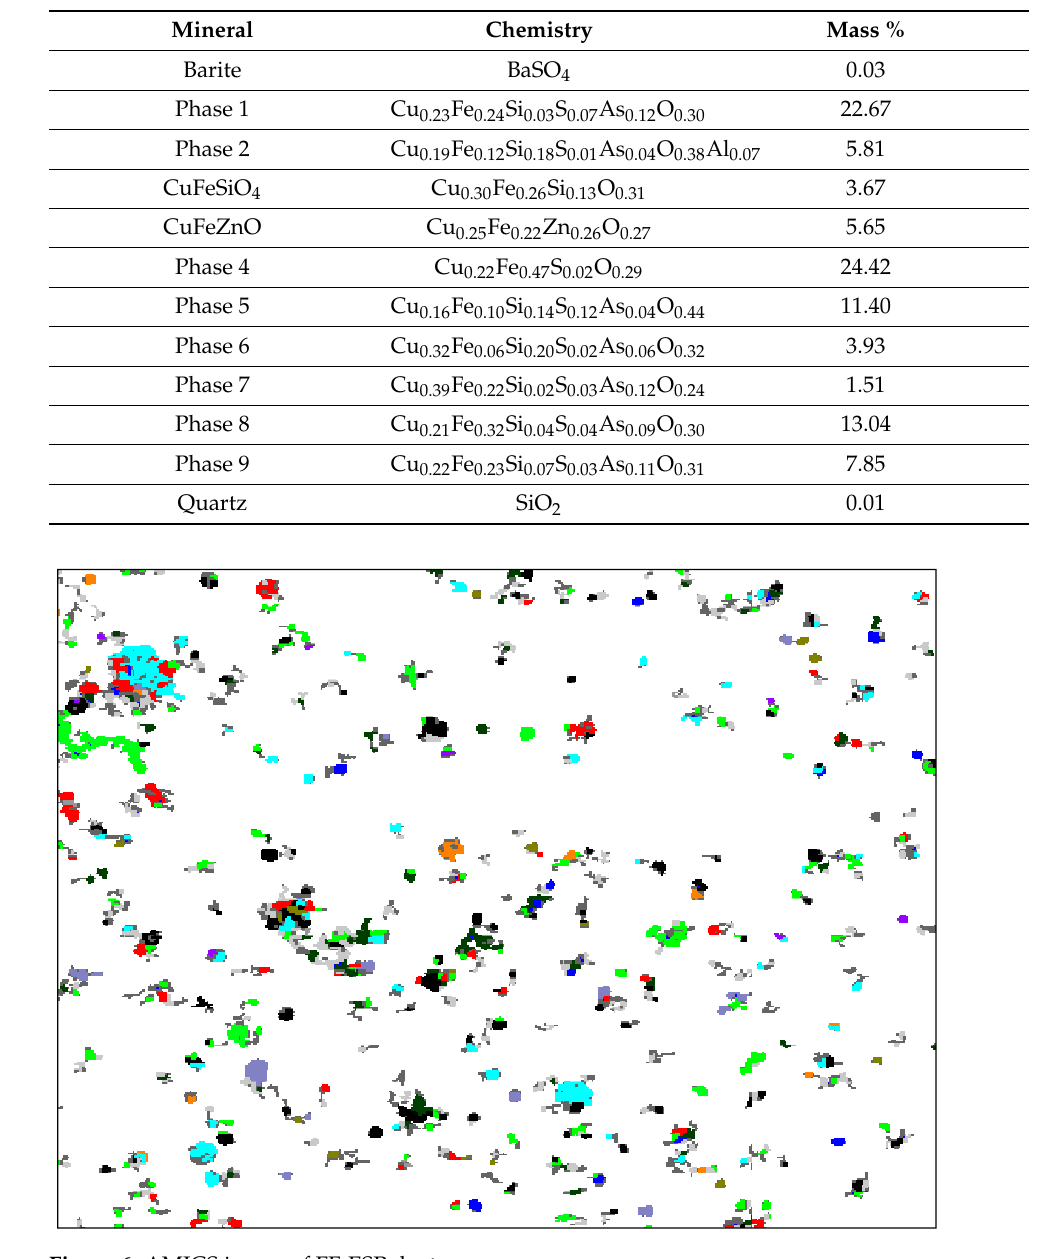
Table 2. AMICS phase composition of FF-ESP dust.